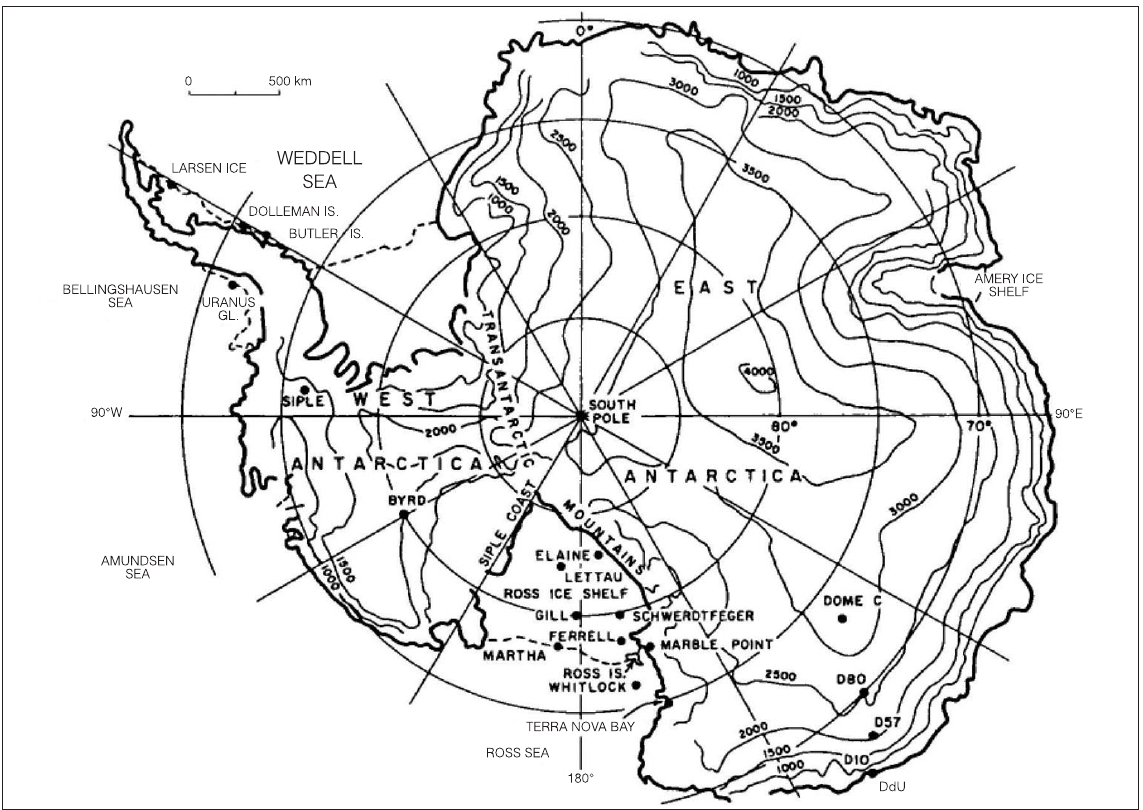
Fig. 1. The map of Antarctica showing height contours and the location of Dumont d’Urville and Dome